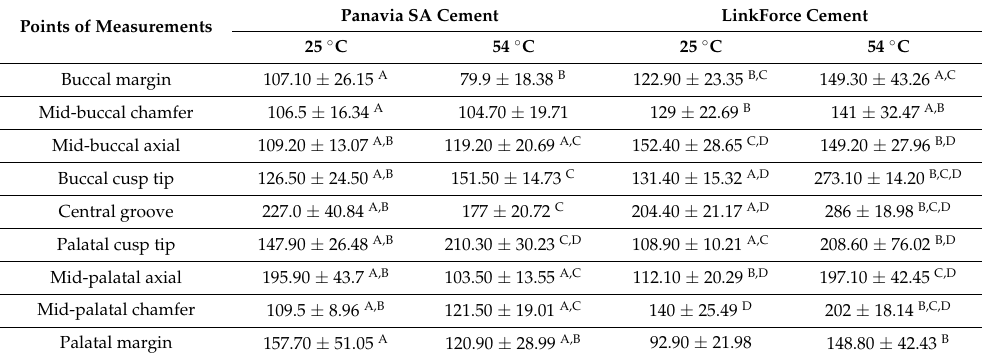
Table 2. Means and standard deviations of the marginal and internal fit ( μ m) of the studied groups.